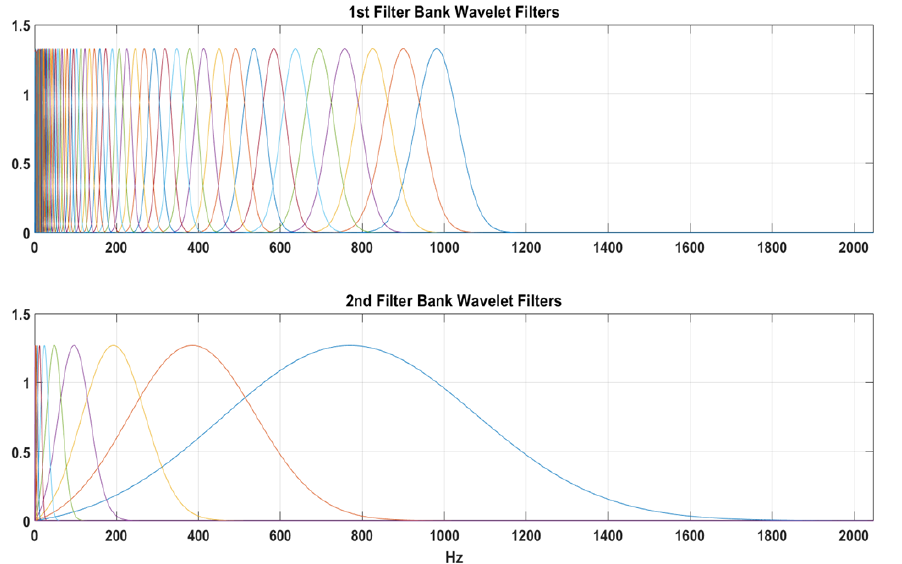
Figure 18. Wavelet scattering network’s filter banks at each